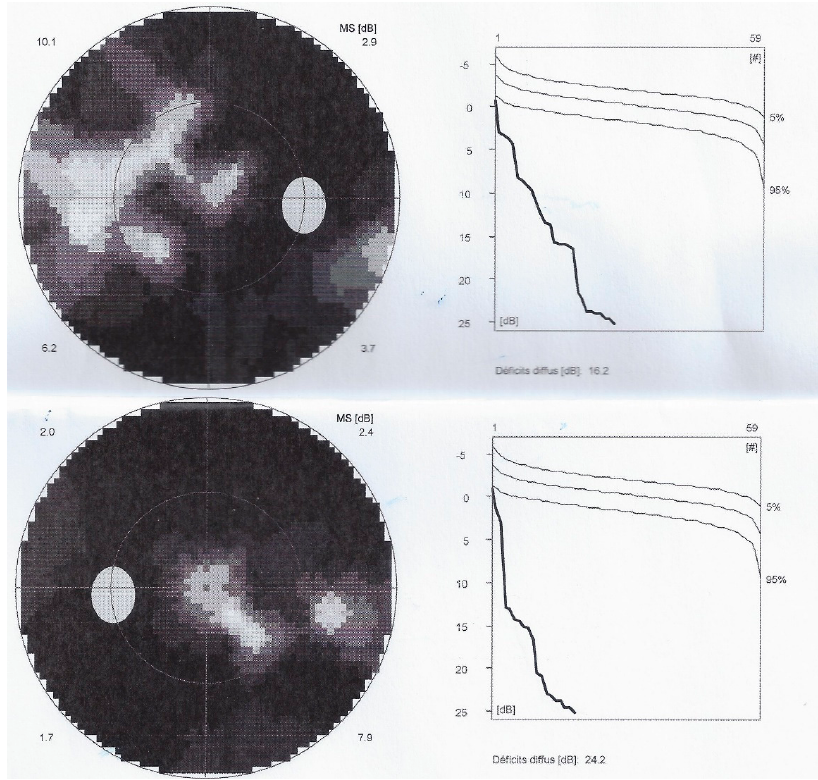
Figure 12. Visual fields ODS in AZOOR patient 3 at presentation. Severe visual fields loss ODS.